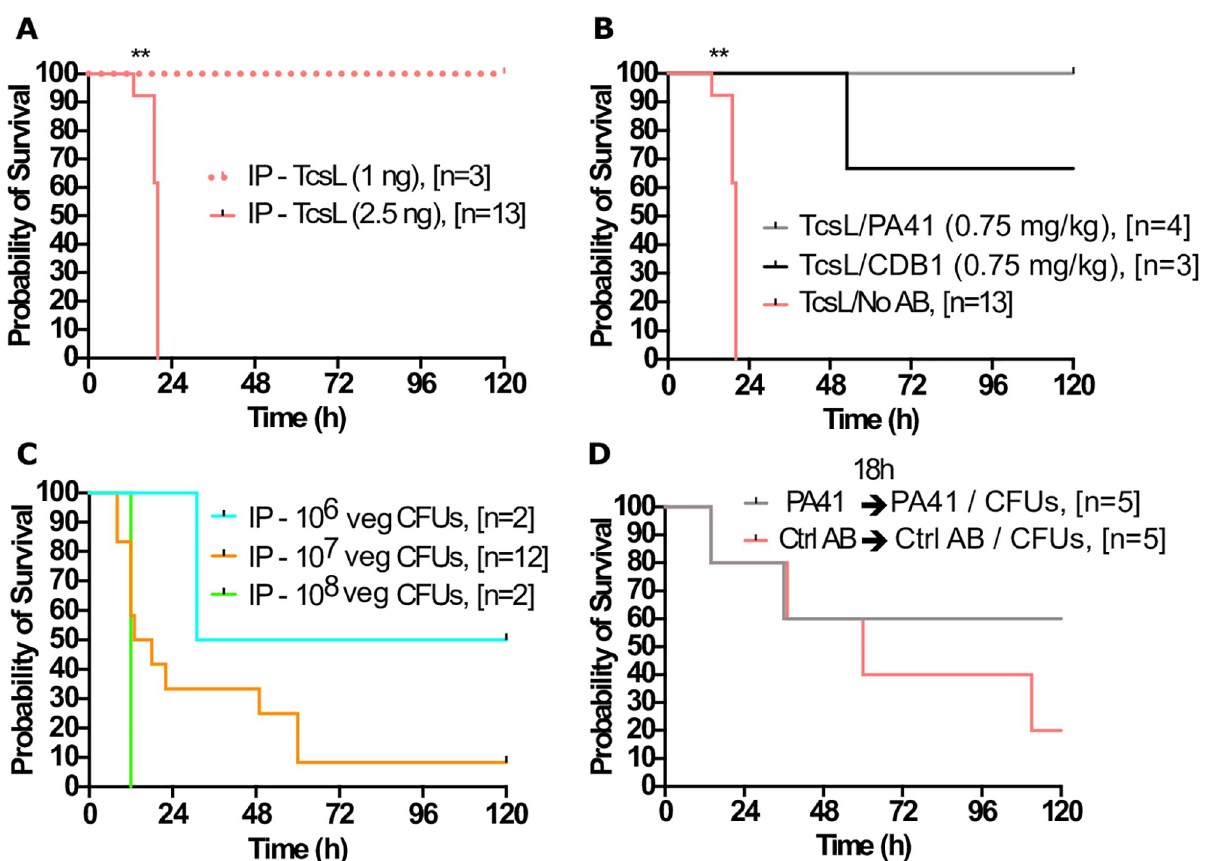
Fig 2. PA41 and CDB1 neutralization of rTcsL and P. sordellii vegetative bacteria, in vivo , following intraperitoneal injection. (A) Mouse survival curve following IP injection of 1ng and 2.5ng TcsL. (B) Mouse survival curve following IP intoxication of 2.5ng TcsL alone or in the presence of PA41 (0.75 mg/kg) or CDB1 (0.75 mg/kg). (C) Mouse survival curve following IP infections of 10 6 , 10 7 , 10 8 CFUs of vegetative P . sordellii strain ATCC 9714. (D) Mouse survival curve following 7.5 mg/kg PA41 or PA50 (control antibody) administered 18h prior to co-IP instillation of 7.5 mg/kg antibody and 1x10 7 CFUs of ATCC 9714 vegetative bacteria. Log-rank (Mantel-Cox) multiple comparison test was used with statistical significance set at a p value of <